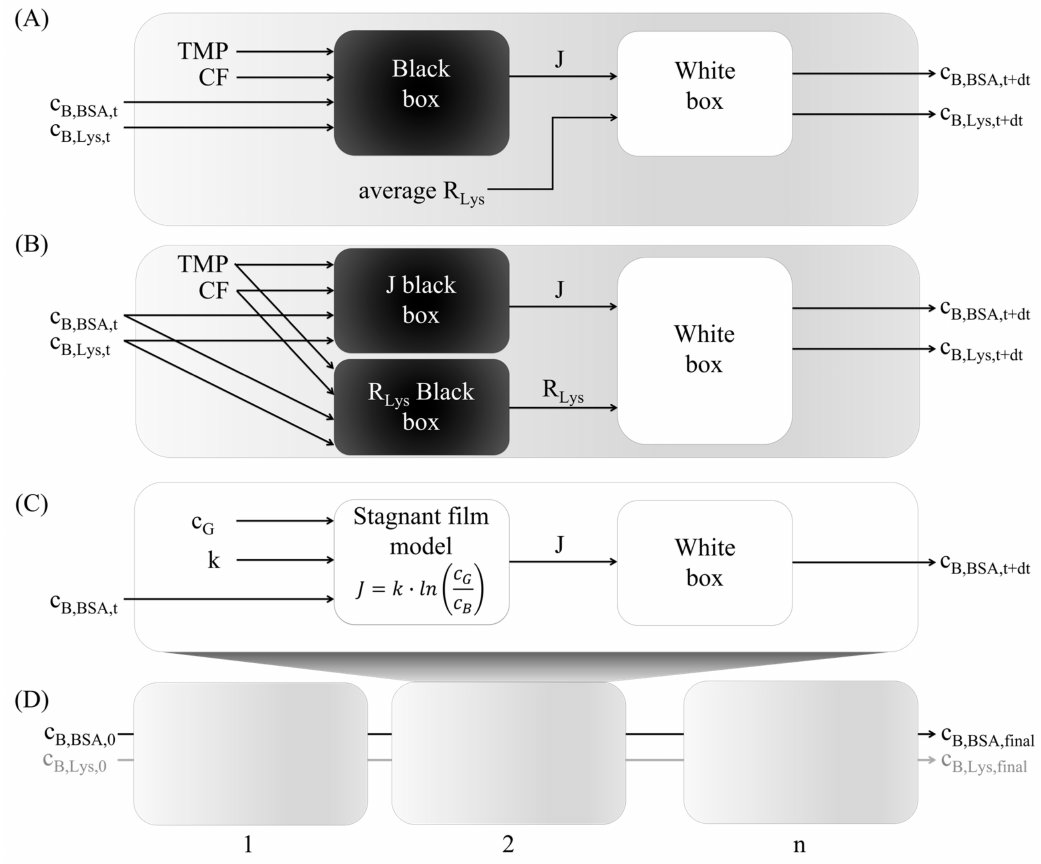
Figure 1. Schematic representation of the two hybrid model and mechanistic model structures, with implementation in the multi-step ahead model. ( A ) Hybrid model 1 (HM 1) using static, average R Lys from the training set, ( B ) hybrid model 2 (HM 2) with two separate black boxes for flux and dynamic R Lys prediction, ( C ) stagnant film model (SFM). ( D ) Multi-step ahead hybrid model